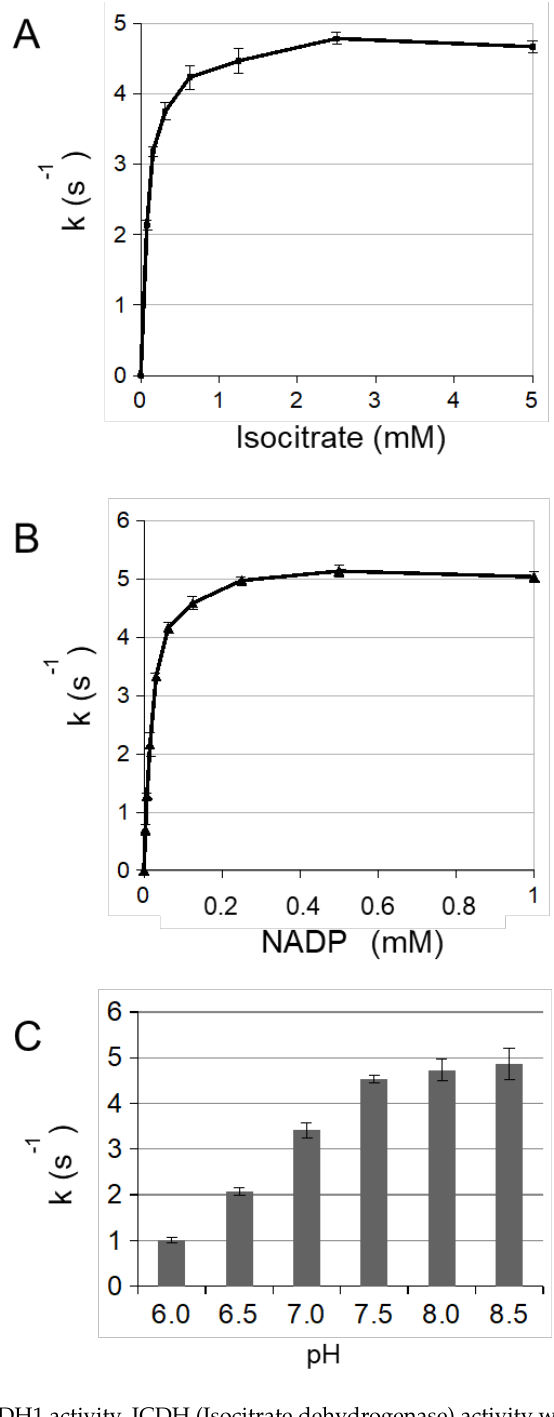
Figure 1. Cytosolic ICDH1 activity. ICDH (Isocitrate dehydrogenase) activity was measured for 800 ng of ICDH by monitoring the change in absorbance at 340 nm due to the isocitrate-dependent rate of NADP + reduction at 25 ◦ C in 1 mL reaction medium containing 5 mM MgCl2, 250 µ M of NADP + and ( A ) different concentrations (0–5 mM) of DL-isocitric acid or ( B ) different concentrations (0–1 mM) of NADP in 100 mM phosphate buffer (KOH, pH 7.5). ( C ) 2.5 mM DL-isocitric acid in 100 mM phosphate buffer at different pH (6–8.5). Error bars represent SE (Standard Error) ( n =